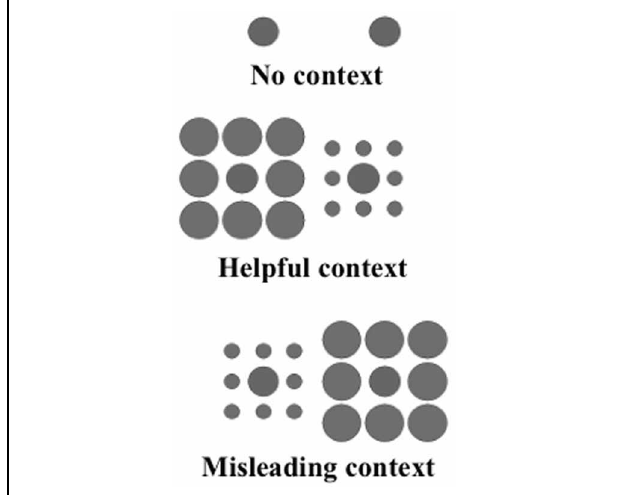
FIGURE 2 | Ebbinghaus illusion stimuli. This figure illustrates the stimuli used for the Ebbinghaus illusion task. The top panel shows an example of the no outer context trials, the middle panel shows an example of the helpful context trials and the bottom panel is an example of the misleading context trials. In all three panels, the left center circle is 2 pixels smaller than the right center